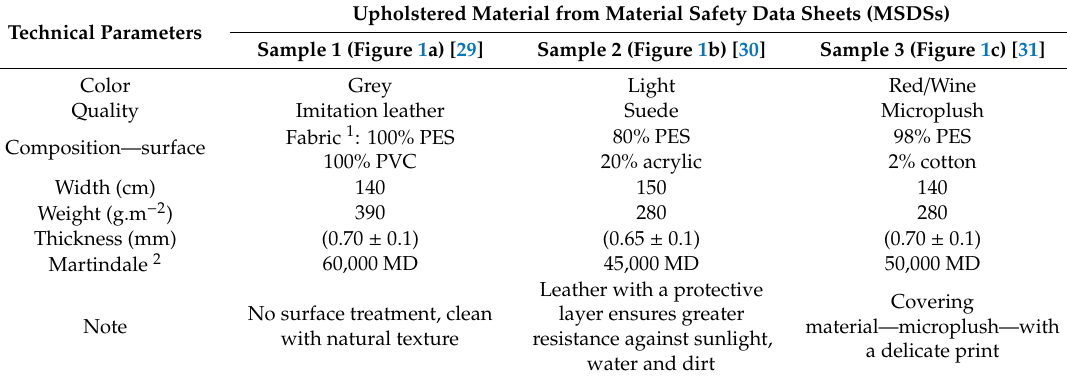
Figure 1. Pictures of the three samples. ( a ) Imitation leather, ( b ) suede, and ( c ) microplush. Table 2. Technical parameters of the upholstered